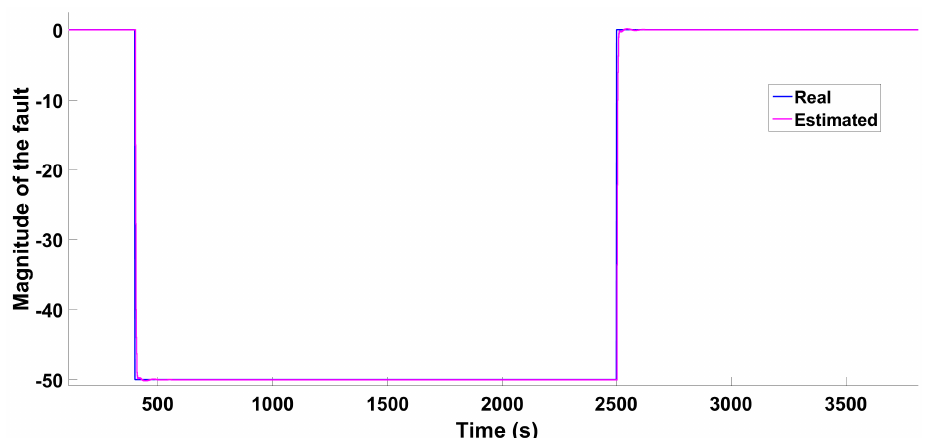
Figure 17. Scenario 1 − Step-type fault: Real and estimated step-type fault on the reduced model (Hammerstein −